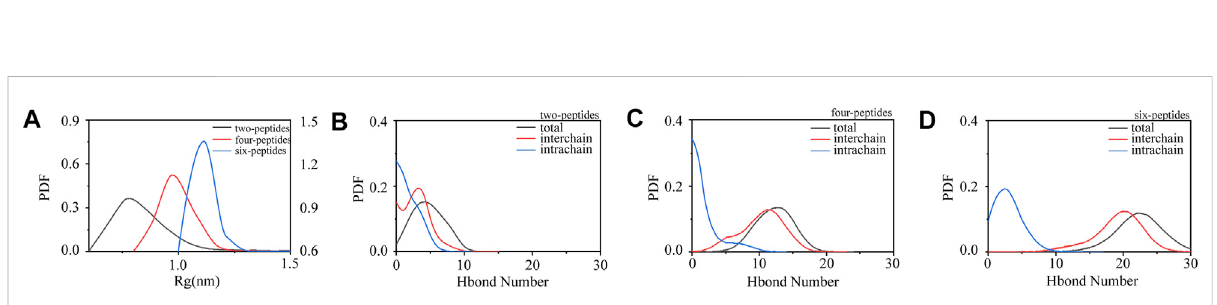
FIGURE 2 Conformationaldifferencesoftwo-,four-,andsix-peptidesofTTR(105 – 115). (A) Theradiusofgyrationispresentedasfunctionofprobabilityin eachresearchsystem. (B – D) Theprobabilitydistributionfunctionofthenumberofintrachain,interchain,andtotalbackbonehydrogenbondsforthe two-, four-, and six-peptides